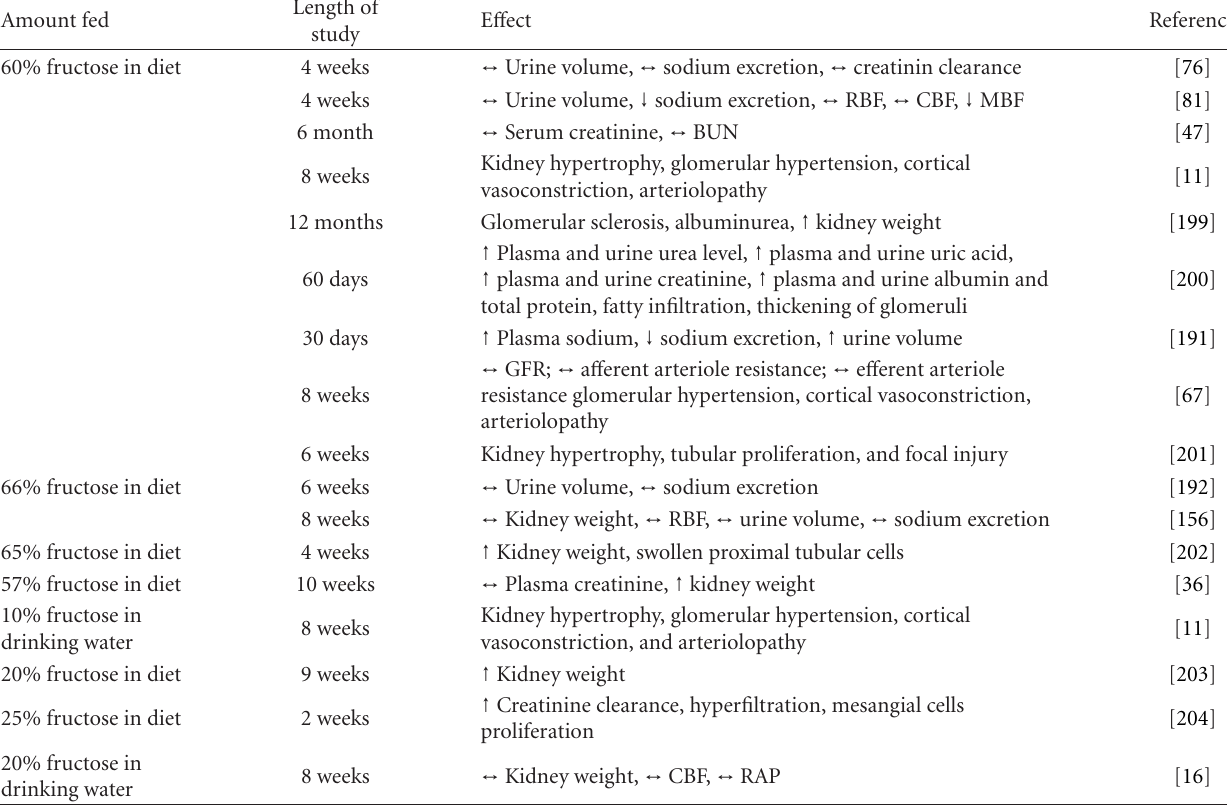
Table 3: The e ff ect of fructose feeding on kidney morphology, function, and haemodynamics in